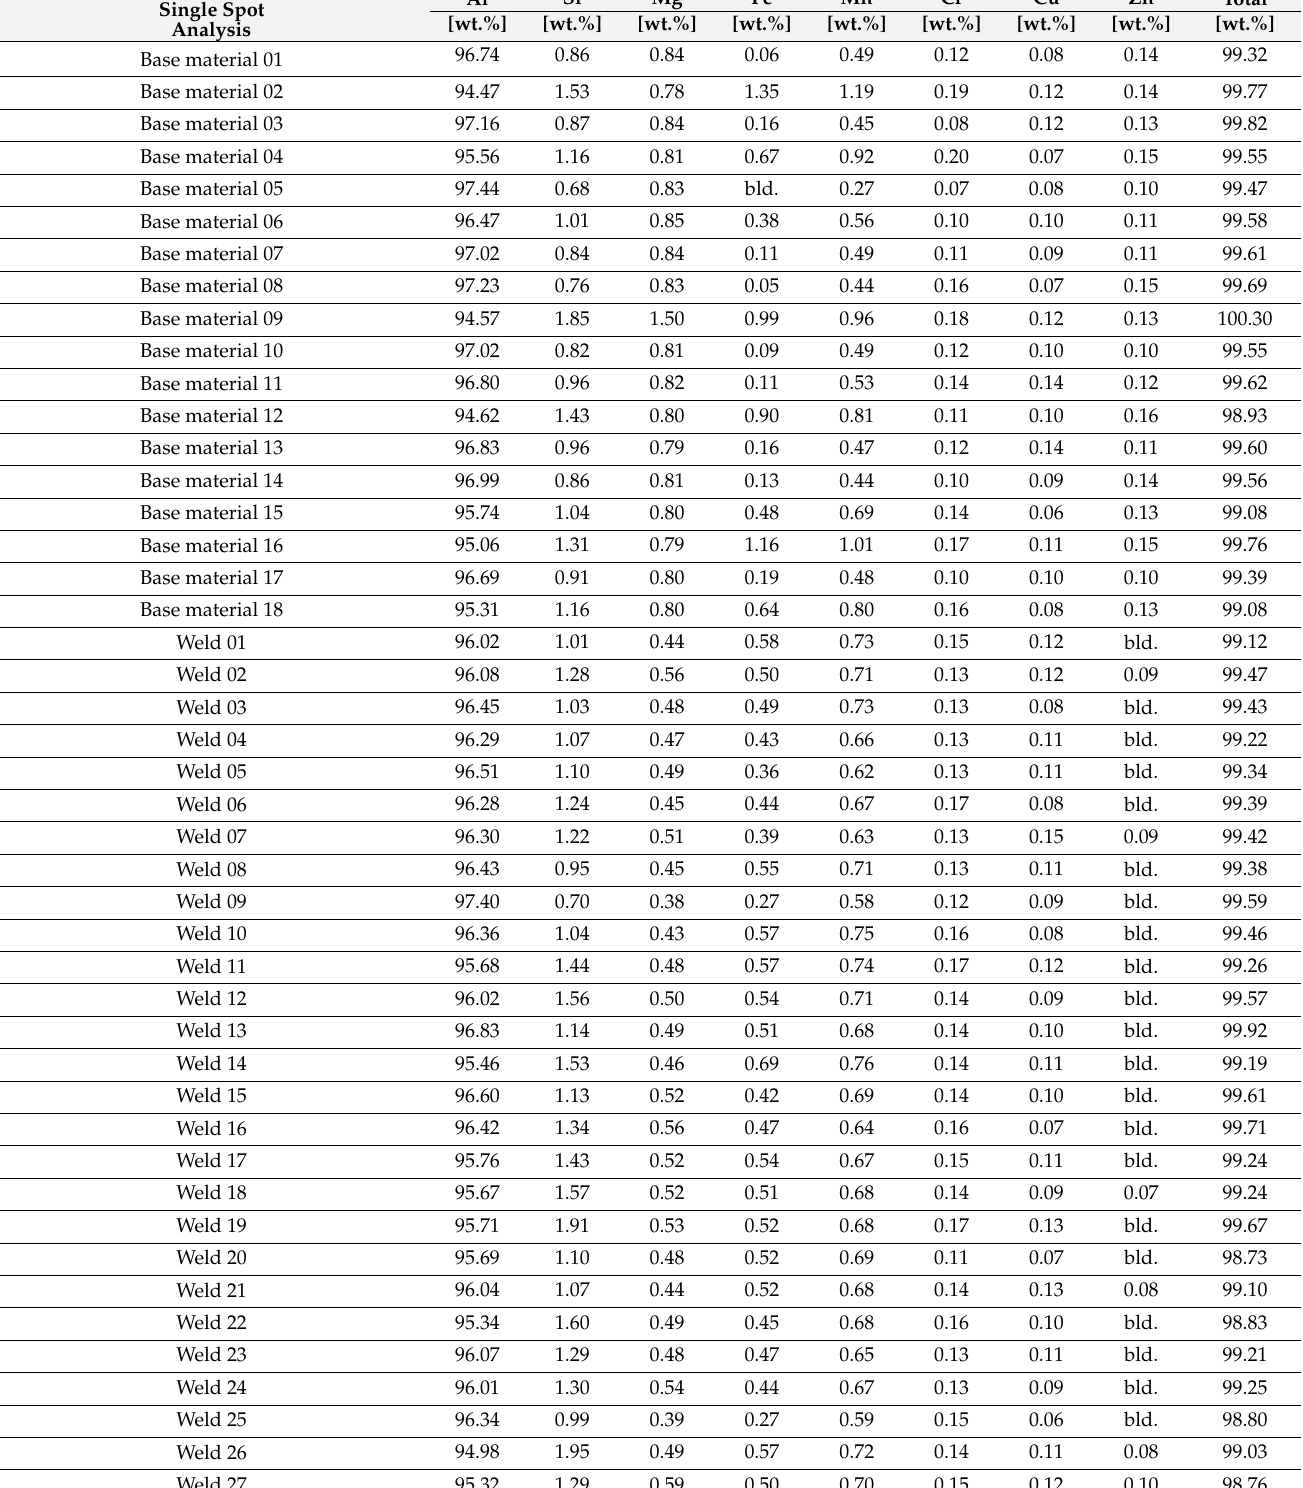
Table A1. Single spot EPMA analyses of the Al-phase in the base material and in welded areas. bld.: below detection